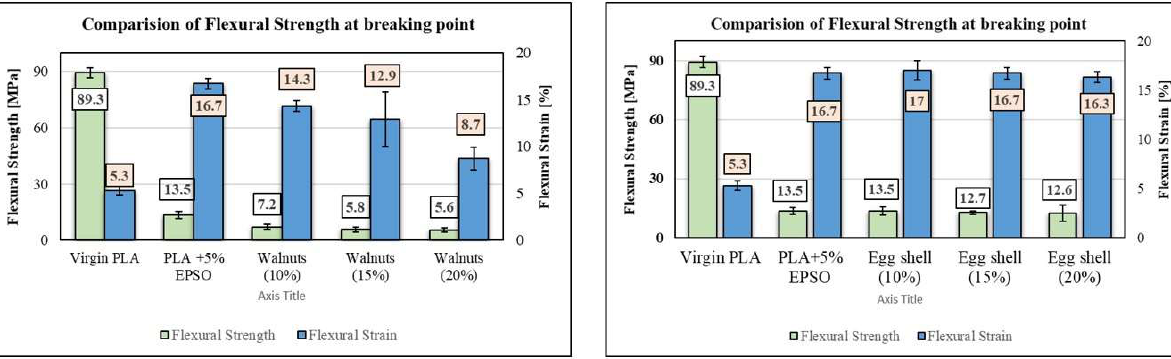
Figure 9. Flexural test result—Flexural strength [MPa] at the breaking point comparison.